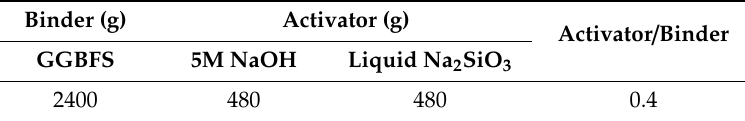
Table 2. Mix proportions of samples.